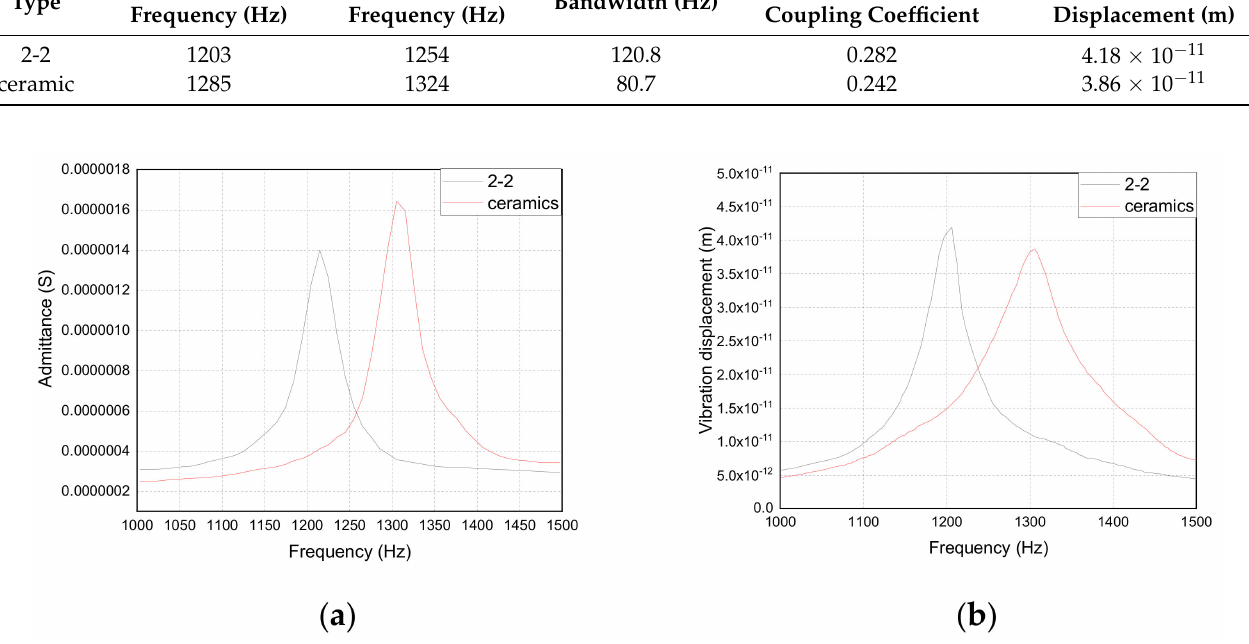
Figure 12. Test results of admittance curve and vibration displacement curve: ( a ) admittance curve; ( b ) vibration displace- ment